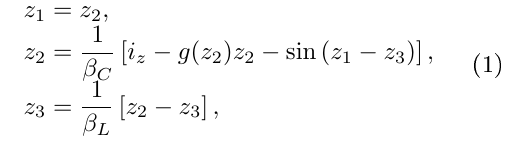
Fig. 1: Chaotic motion in Josephson